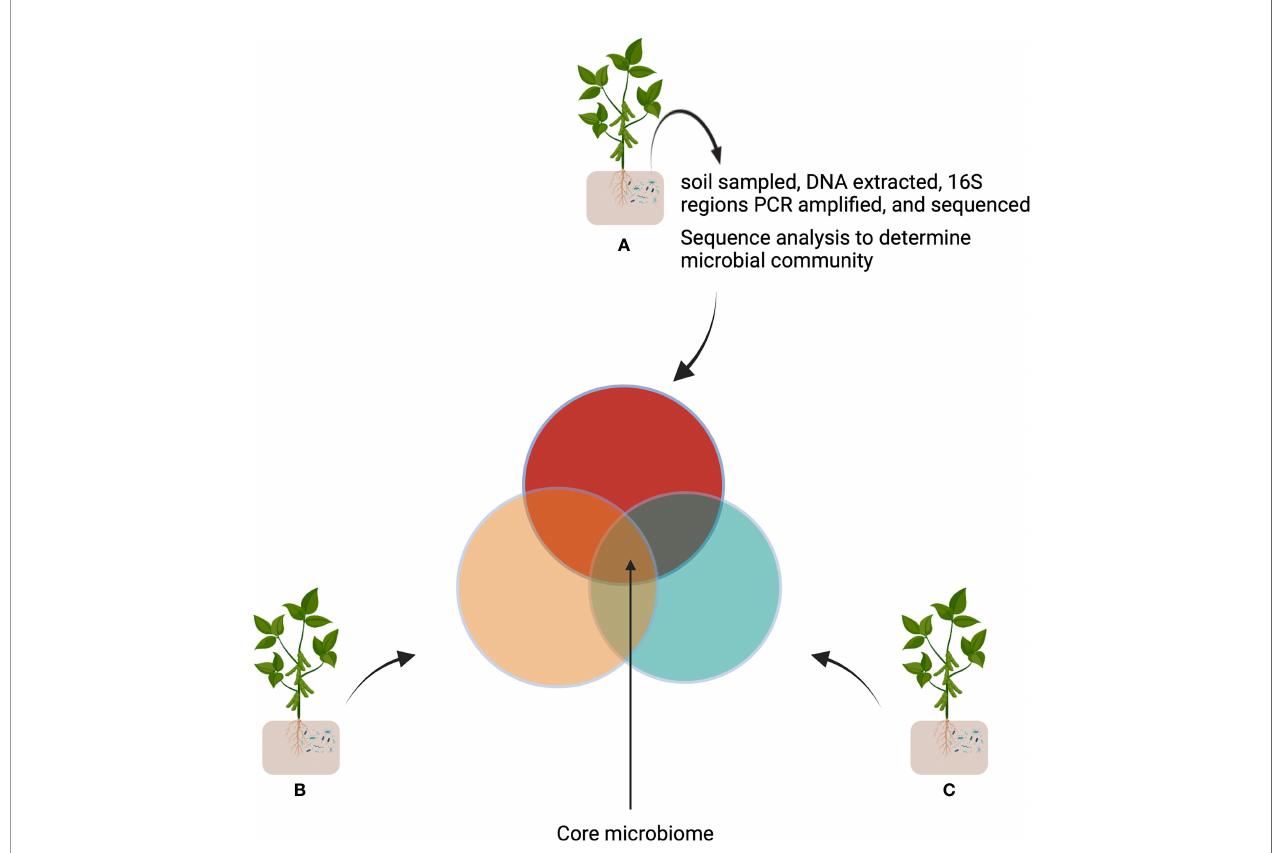
FIGURE 2 | Determination of a core microbiome. The same plants are grown in independent locations (A-C) . The soil is then sampled, sequenced, and the bacterial population (colored circles) are determined and compared (Venn diagram). The intersection represents the plants core microbiome. This fi gure was created with